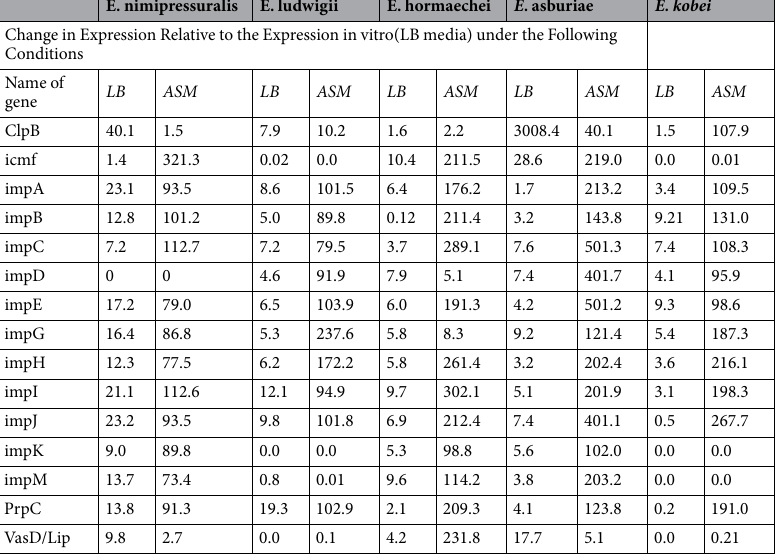
Table 2. Comparative gene expression profile of type six secretion systems in Enterobacter cloacae complex in ASM and LB medium optimized at log phase. The changes in gene expression or variations were two-fold higher than those in the control ( in vitro or LB medium